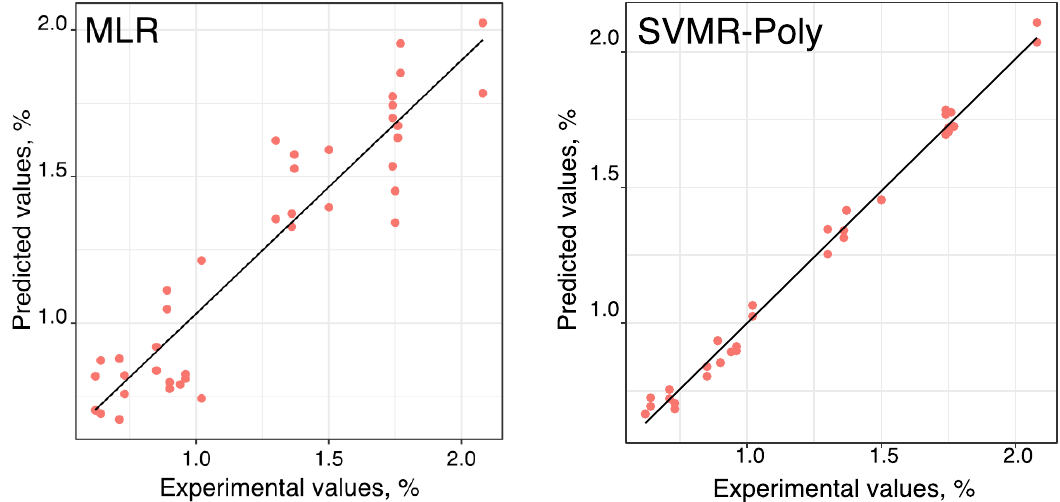
Figure 4. Representation of the linear relationship between the predicted values by MLR and SVMR-Poly models and the experimental values of IMF%. MLR—multiple linear regression; SVMR-Poly—polynomial support vector machine regres- sion; IMF%—percentage of intramuscular fat.